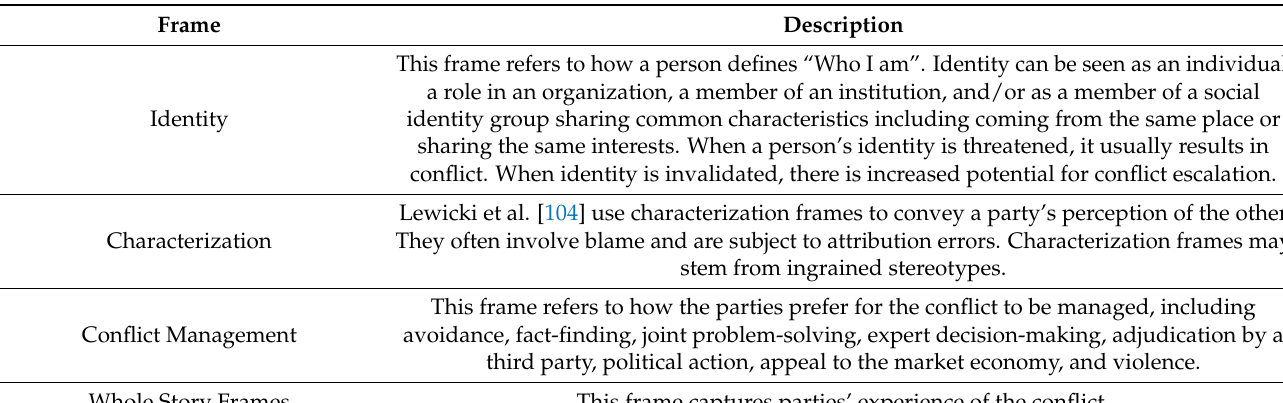
Table 1. Main terms of the framing approach (own